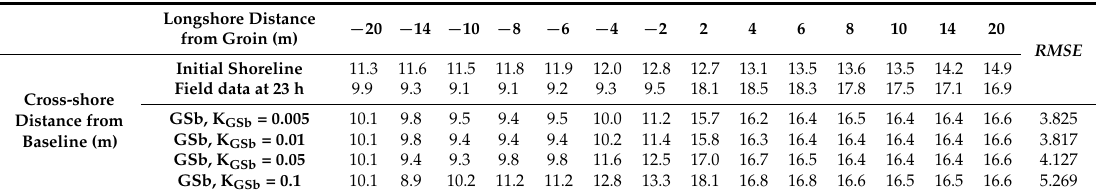
Table 3. Calculated and observed shoreline positions at 14 transects along the shoreline and relative values of RMSE (Root Mean Square Error).